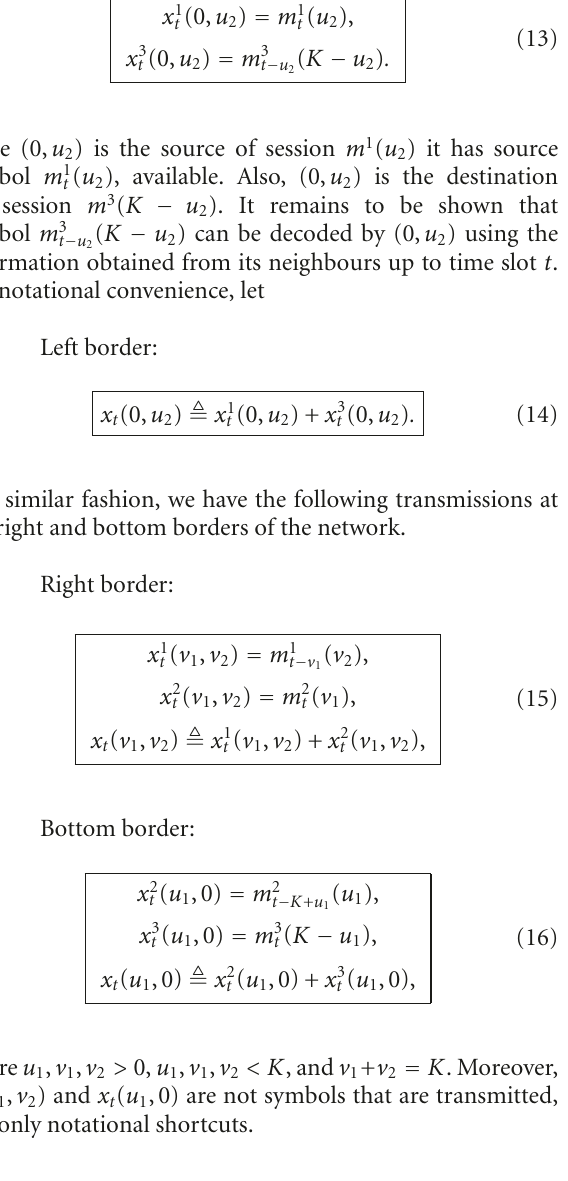
x 1 t (0, u 2 ) and x 3 t (0, u 2 ), where Left